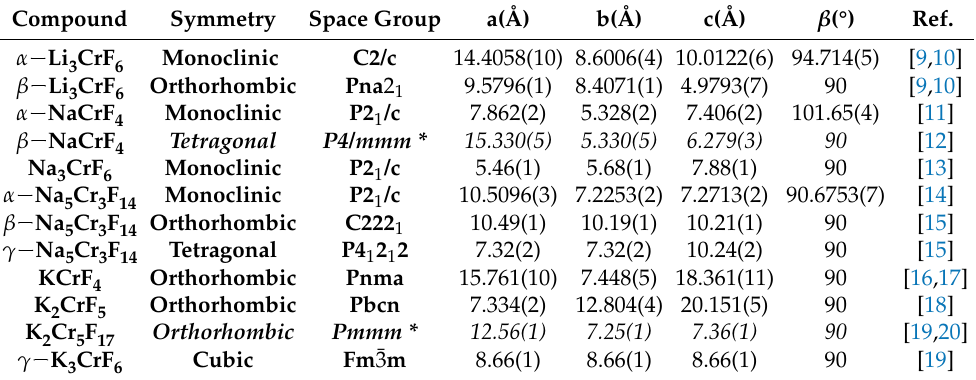
Table 1. Lattice parameters of the intermediate compounds of the AF CrF 3 (A = Li, Na,K) systems. Compound Symmetry Space